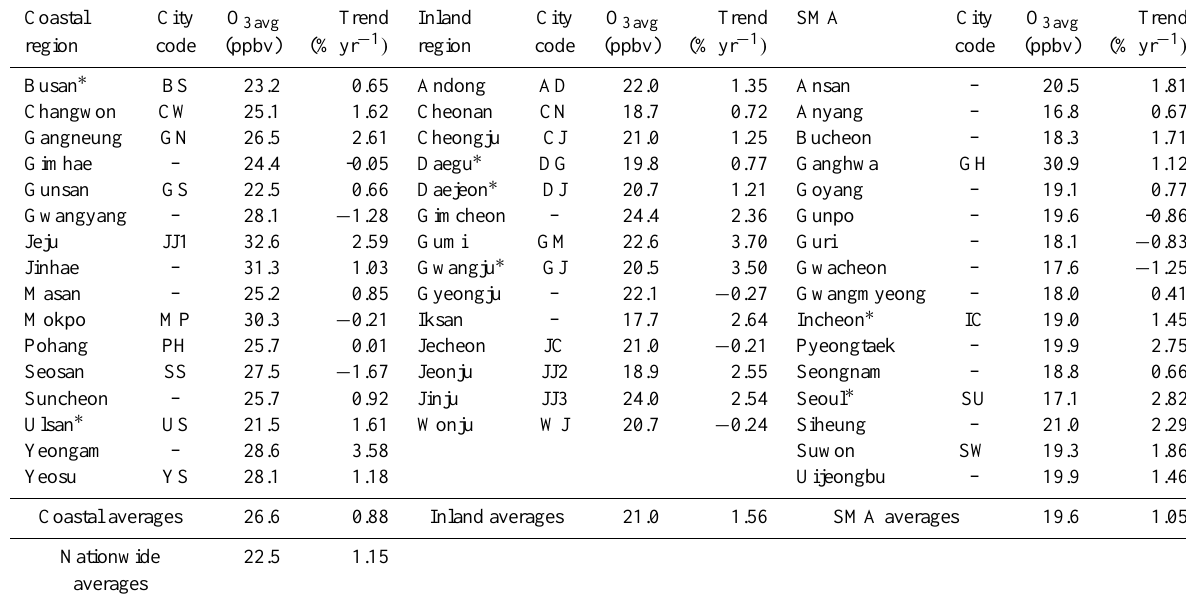
Table 1. 12yr averaged concentrations and temporal linear trends of daily average O 3 (O 3avg ) at 46 cities over South Korea for the period 1999–2010. The cities are categorized into three groups: 16 coastal cities, 14 inland cities, and 16 cities in the SMA.